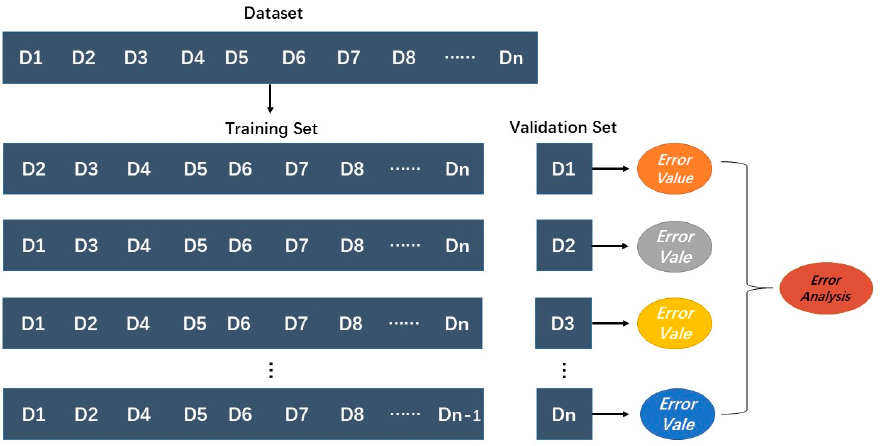
Figure 3. Schematic diagram of leave-one-out method.